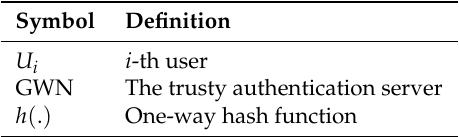
Table 1. The symbol system applied by the proposed